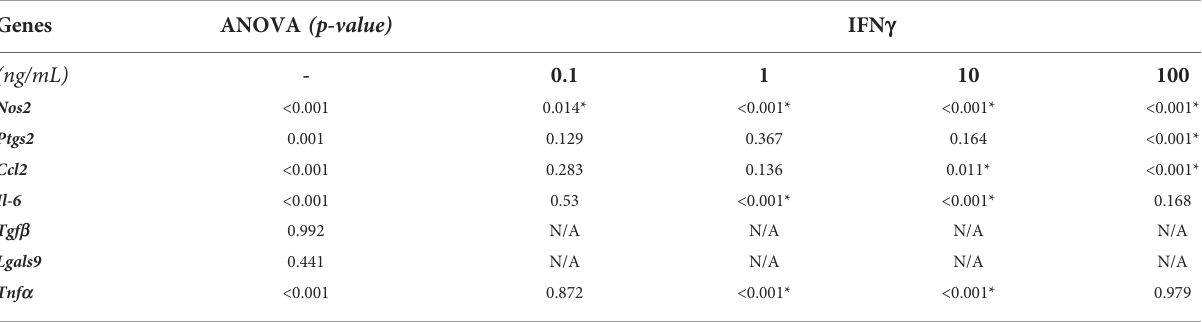
TABLE 2 IFN g licensing is concentration-dependent – Groupwise comparison. Holm-Sidak Pairwise Comparison (vs. Control) (p-value) Genes